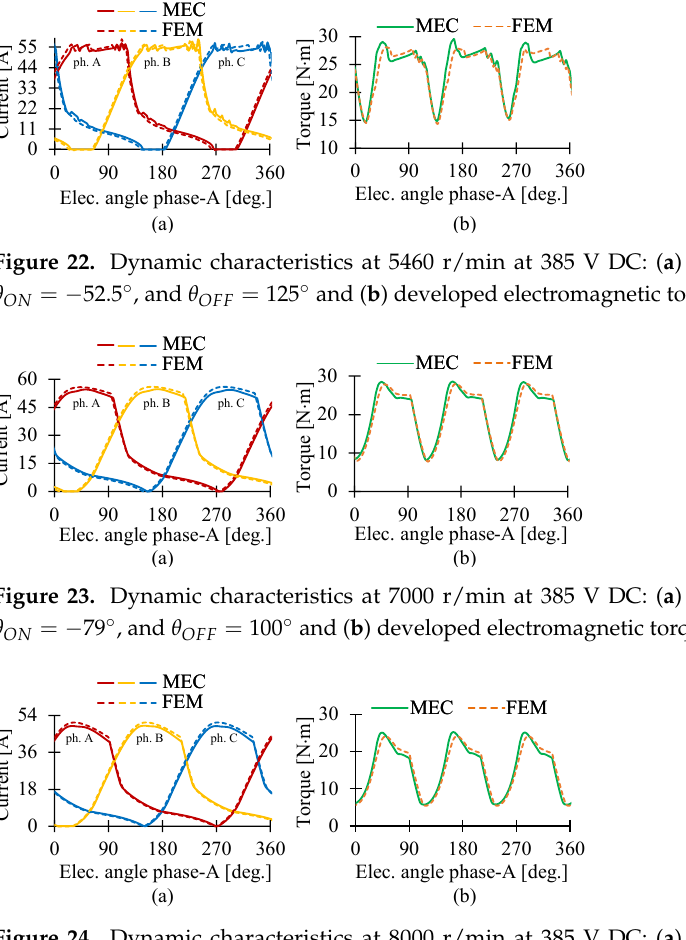
Figure 24. Dynamic characteristics at 8000 r/min at 385 V DC: ( a ) phase currents I ref = 55 A, θ ON = − 85 ◦ , and θ OFF = 95 ◦ and ( b ) developed electromagnetic torque. Table 10. Comparison of RMS current, average torque, and peak–peak torque ripple from the MEC and FEM